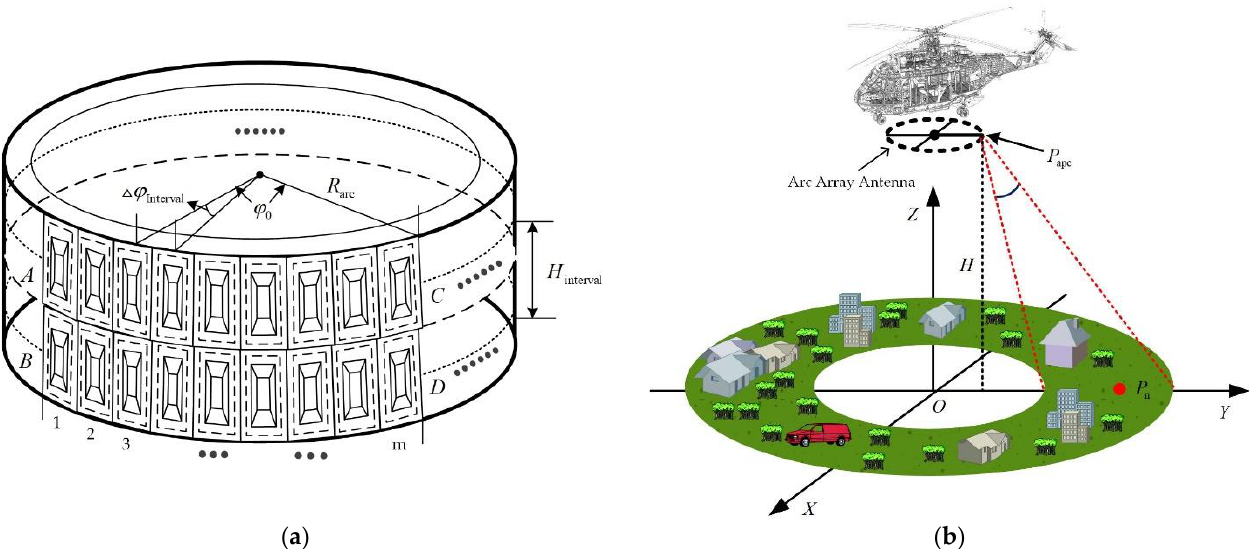
Figure 1. Antenna array and imaging geometry. ( a ) Arc array antenna distribution diagram; ( b ) geometric scenarios for arc array SAR imaging.